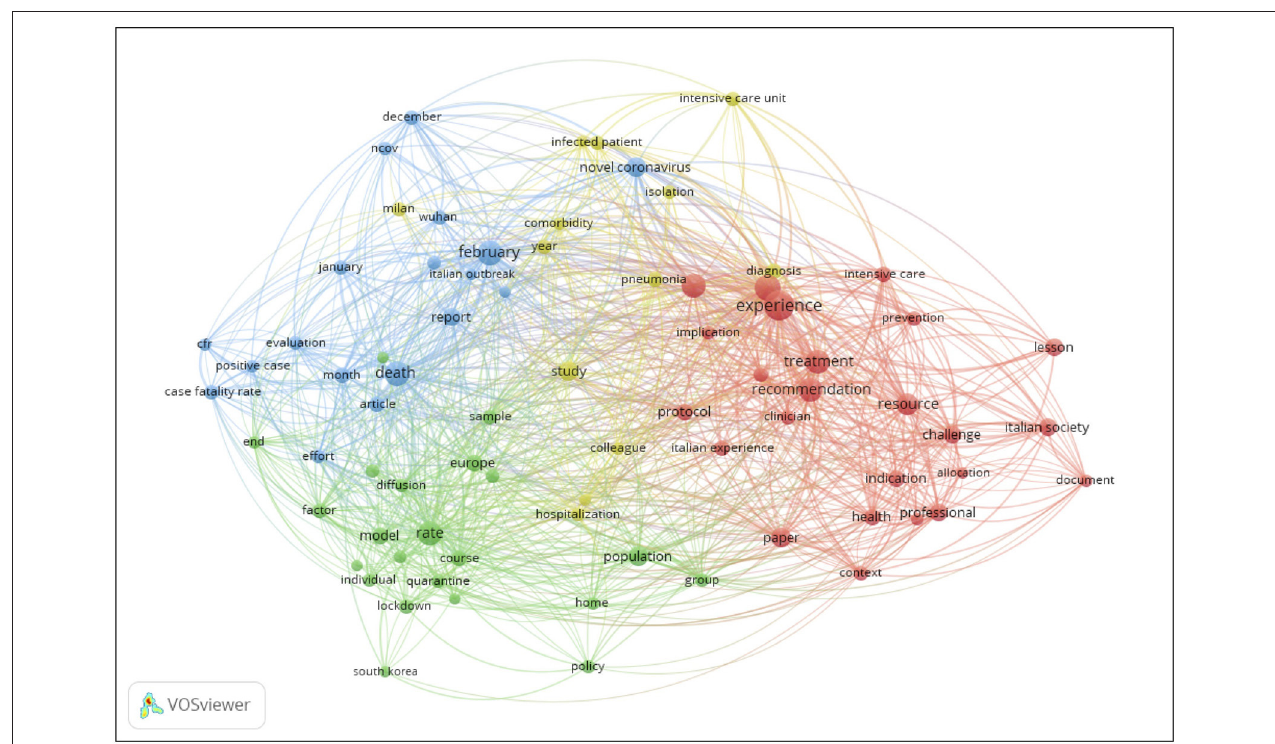
FIGURE 2 | Co-occurrence analysis using VOSviewer of terms in titles and abstracts of Italian